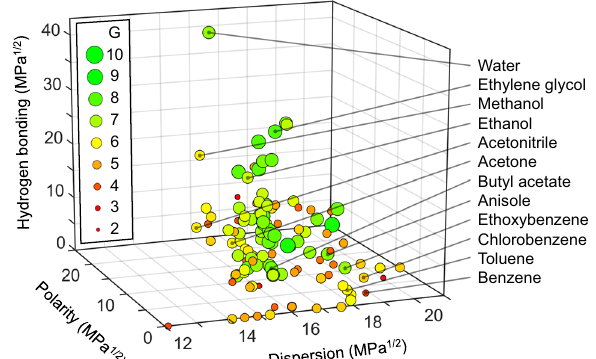
Fig. 1 Visualization of the localization and the composite score, G , of the solvents in the Hansen space. The distribution of 132 common solvents in the 3D Hansen solubility space, as spanned by the three Hansen solubility parameters: dispersion, polarity and hydrogen bonding. The effective R a distance between two solvents in the 3D Hansen space provides information on their similarity in solubility properties, with a smaller R a value indicating a higher similarity in solubility. The size and traf fi c-light- color coding of the sphere representing a particular solvent communicate its GSK composite score, as speci fi ed in the inset, with a large green sphere indicating a benign solvent while a small red sphere marks a problematic